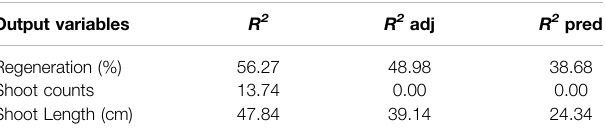
TABLE 2 | Response surface regression models for in vitro regeneration of common bean.